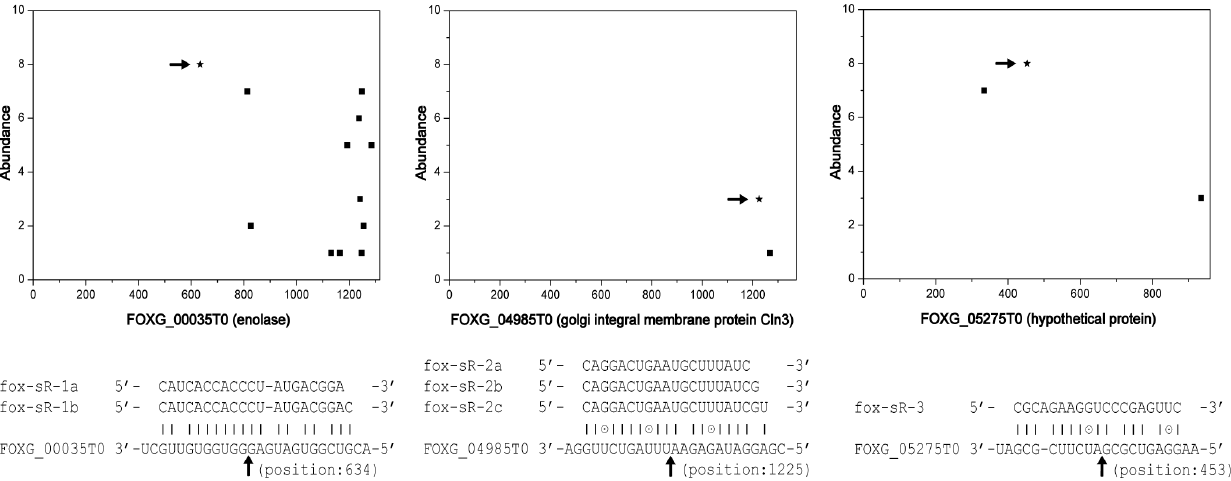
Figure 4. Illustration of three pairs of small RNAs and target transcripts. Scatter plot diagrams show the frequency of tags and their positions on transcripts. The inferred cleavage sites were indicated by the asterisks and arrows. Although the abundance of tags and small RNAs was relative low, the corresponding small RNAs were experimentally validated by RT-PCR ( Fig. 2C ).